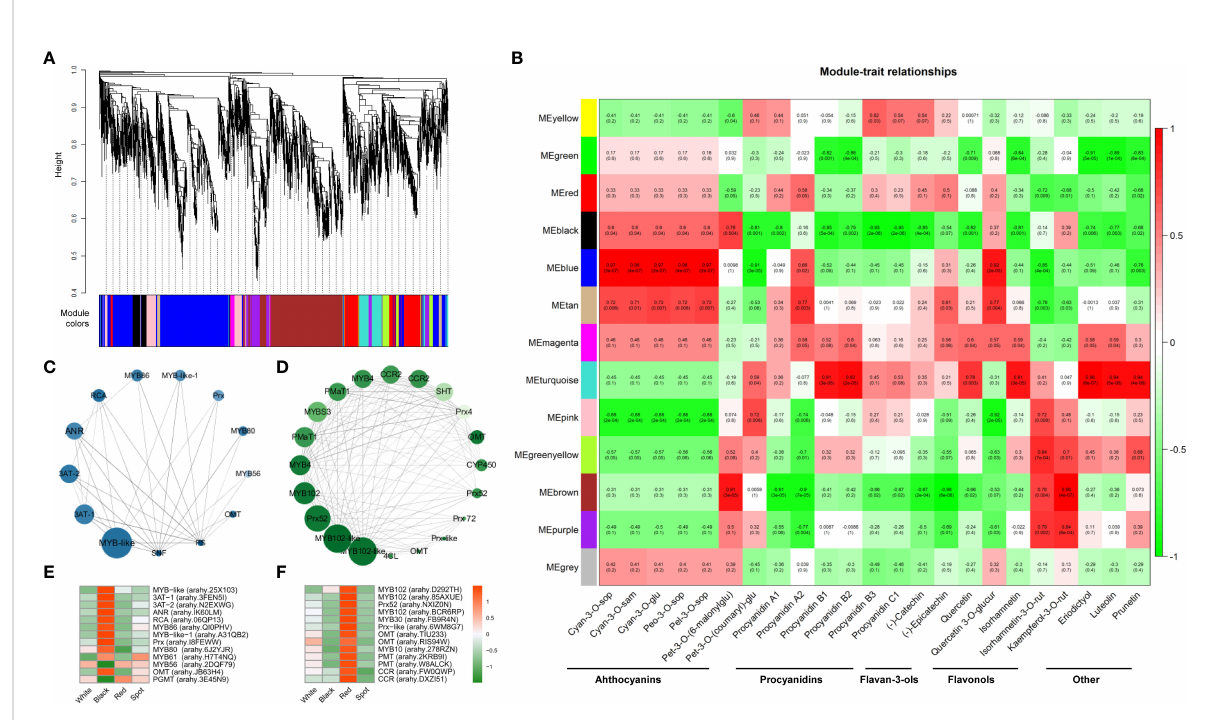
FIGURE 6 Identi fi cation of hub genes and key modules related to anthocyanin and other fl avonoid metabolites in peanut seed coats by WGCNA. (A) Hierarchical cluster tree shows 13 modules of co-expressed genes. Different modules are marked with different colors. (B) Correlations of fl avonoid contents with WGCNA modules. Each row corresponds to a speci fi c module eigengene, and column to a trait. The values in each cell represent the correlation coef fi cients (r) and the p-values (in parentheses) of the module-trait association. The deeper the red or green in a cell, the higher the positive or negative correlation between the module eigengene and a trait feature. Visualization of co-expression network of blue (C) and turquoise (D) module by Cytoscape software. The top hub genes with the highest degree of connection to other genes are shown in nodes. The size of node corresponds to degree value, and color means module membership value calculated by WGCNA. The larger and darker of the nodes indicate the greater hubness of the gene. Hierarchical cluster analysis of the top hub genes in blue (E) and turquoise (F) module. The values in the heatmap (E, F) represent the z-score of the FPKM (transcript levels) in different samples. Orange color indicates high expression level, while green is